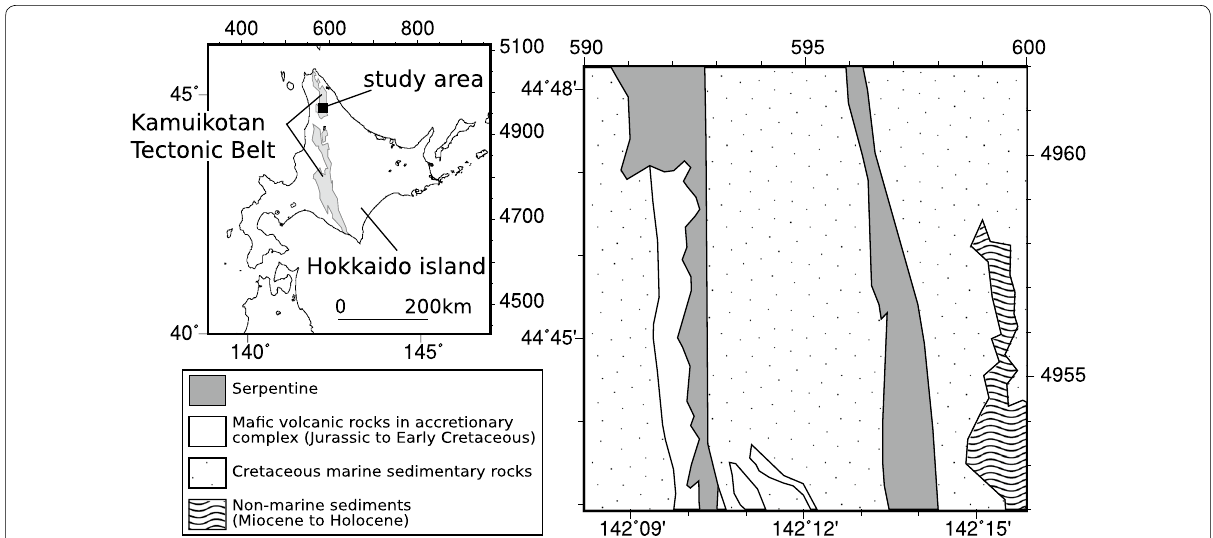
Fig. 20 A simplified geological map of the northern part of Hokkaido Island, Japan. A simplified geological map of the northern part of Hokkaido Island, Japan (Original map is Seamless Digital Geological Map of Japan of GSI: https ://gbank .gsj.jp/seaml ess). The left and lower coordinates of these maps are WGS84 (degree), and right and top coordinates are UTM (km)